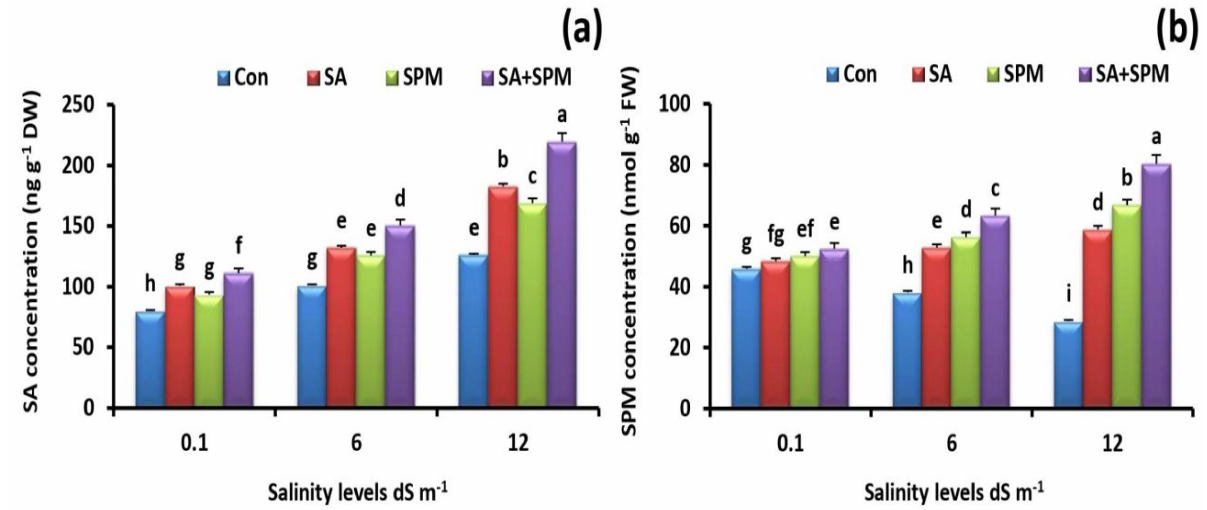
Figure 8. Effect of salicylic acid (SA) and/or spermine (SPM) foliage applications on the endogenous ( a ) salicylic acid and ( b ) spermine concentrations in leaves of wheat plants exposed to non-saline and saline (6.0 and 12.0 dS m − 1 ) conditions. The results showed the mean ± SE of four replicates. Different letters indicate significant differences at ( p < 0.05) level according to Duncan’s